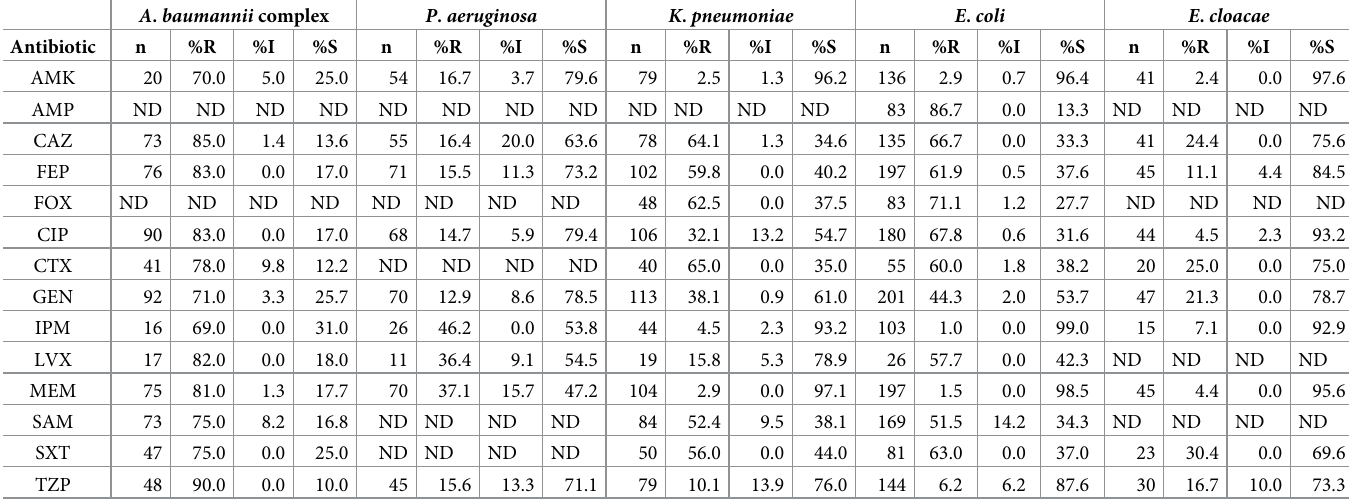
Table 3. Percentage of resistant, intermediate, and susceptible gram-negative isolates collected from blood.